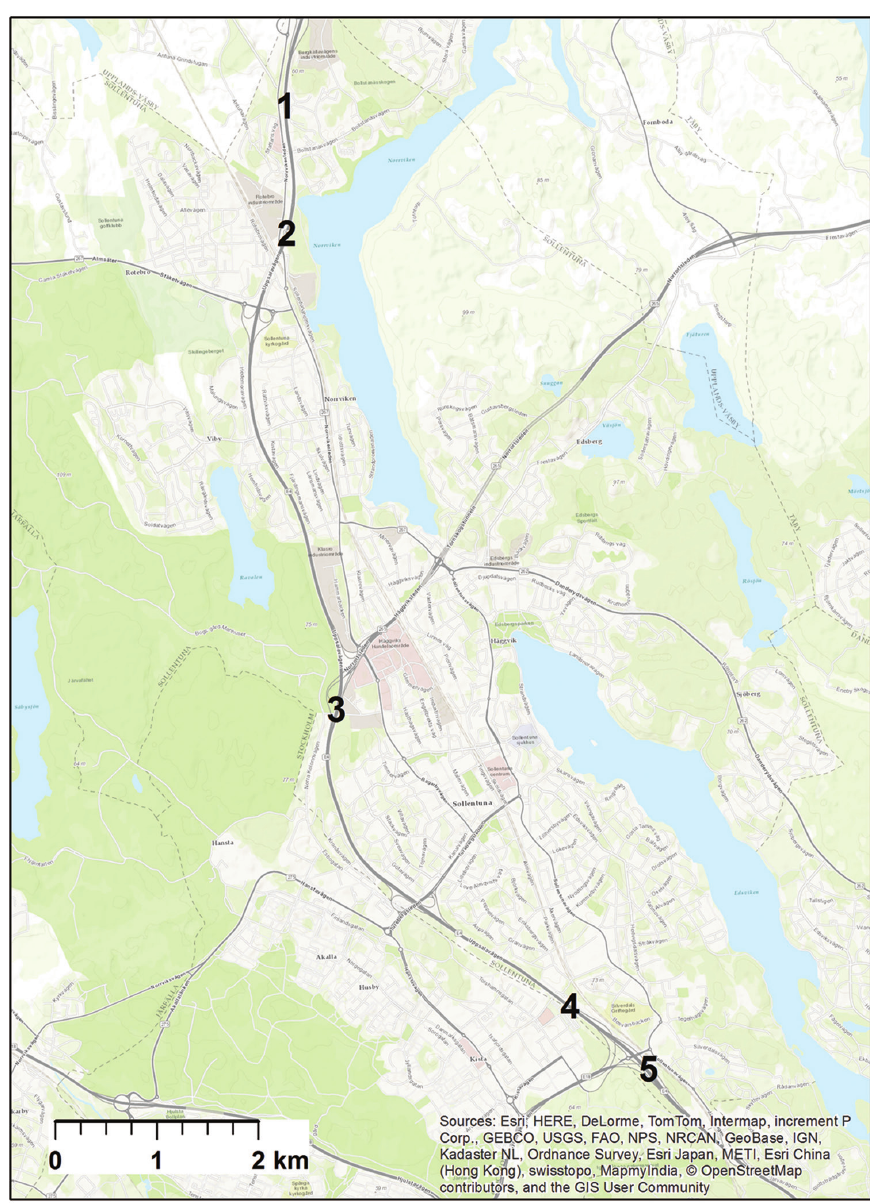
Figure 1. Overview of the study area along the E4 in Sollentuna, showing the five sites where communities of bees and wasps were sampled with two traps on each side of the